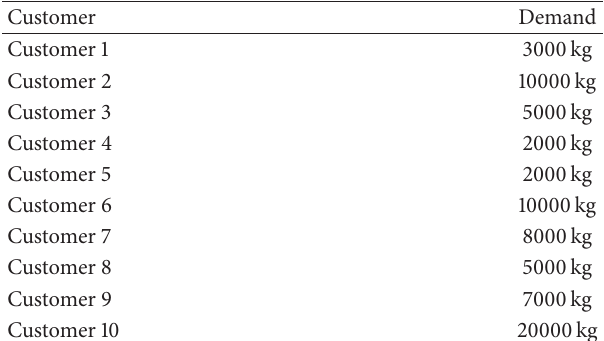
Table 4: The time windows constraints of each customer.